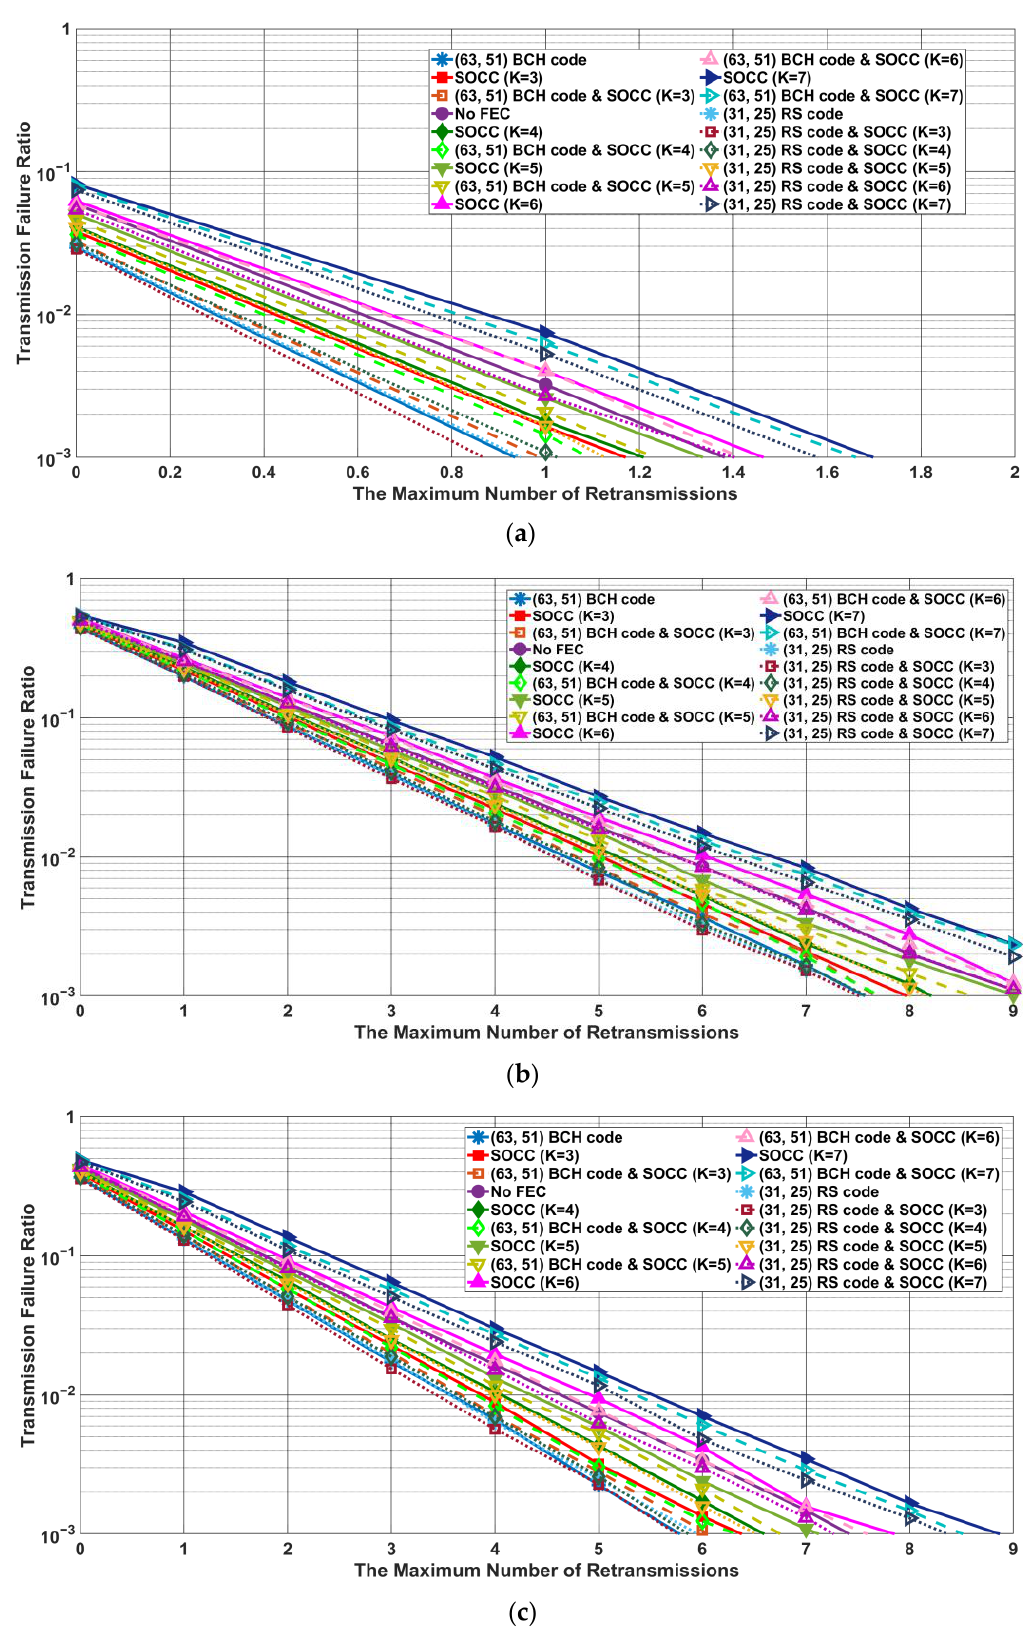
Figure 10. Transmission failure ratio as a function of the maximum number of retransmissions in the case of the burst pulse option with 𝑁 𝑐𝑝𝑏 𝑅 𝑆𝑂𝐶𝐶−1 = 32 for each link type: ( a ) LD, ( b ) MD, and ( c ) HD.